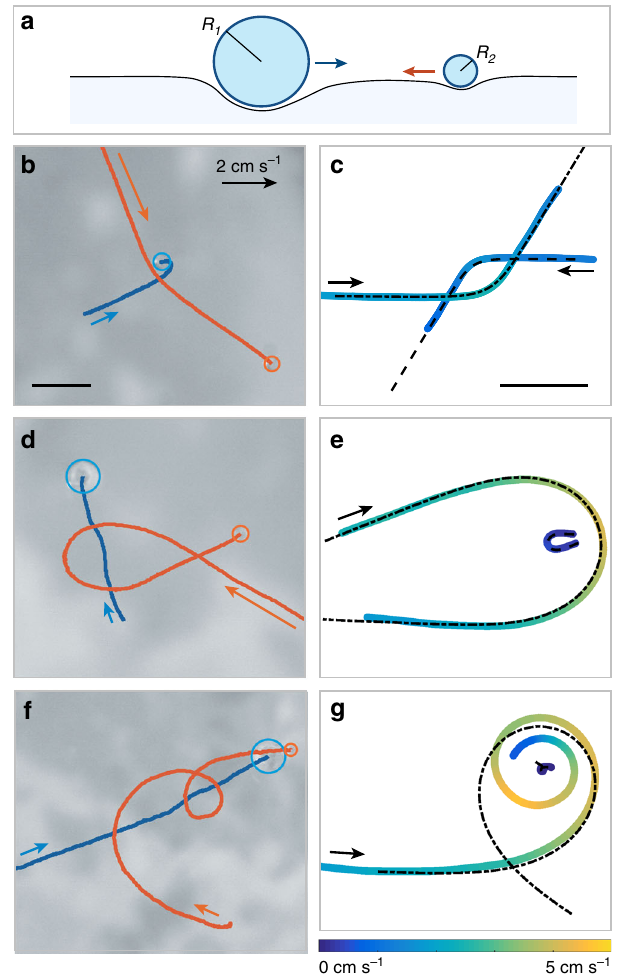
Fig. 1 Orbiting trajectories of two cryogenic skaters. a Two silicone oil drops with radii R 1 and R 2 , deposited on a liquid nitrogen bath, are maintained in an inverse Leidenfrost state and spontaneously self-propel. We study their dynamics as they approach each other, in conditions of negligible friction. b De fl ection between two drops ( R 1 = 410 μ m, in blue and R 2 = 360 μ m, in orange), as seen experimentally. See also Supplementary Movie 1. The arrows indicate the initial direction of motion and velocity of the particles, and the scale bar corresponds to 3 mm. c Same experiment as in ( b ), now plotted in the center of mass frame. The scale bar indicates 3 mm. d Deviation of a small drop ( R 2 = 390 μ m) when approaching a bigger drop ( R 1 = 810 μ m). See also Supplementary Movie 2. e Drop trajectories of ( d ) in the center of mass frame. f Collision trajectory between two frozen marbles ( R 1 = 820 μ m, R 2 = 260 μ m). See also Supplementary Movie 3. g Drop trajectories of ( f ) in the center of mass frame. The scale is the same in panels b , d , and f , and panels c , e , and g . In panels c , e , and g the color code indicates the drop velocity, from 0 cm s − 1 (dark blue) to 5 cm s − 1 (yellow). The dotted lines show the corresponding theoretical trajectories calculated from the capillary potential E ( r